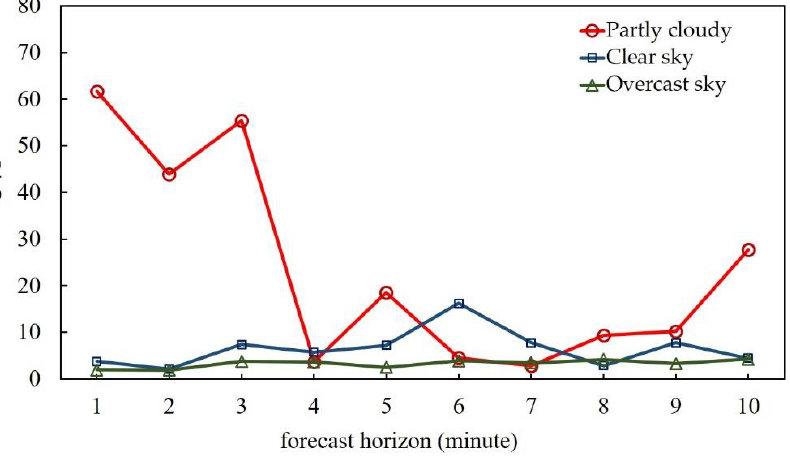
Figure 8. Universal variability index (UVI) for 10 minutes ahead forecasting in different sky conditions: clear sky, partly cloudy, and overcast day.